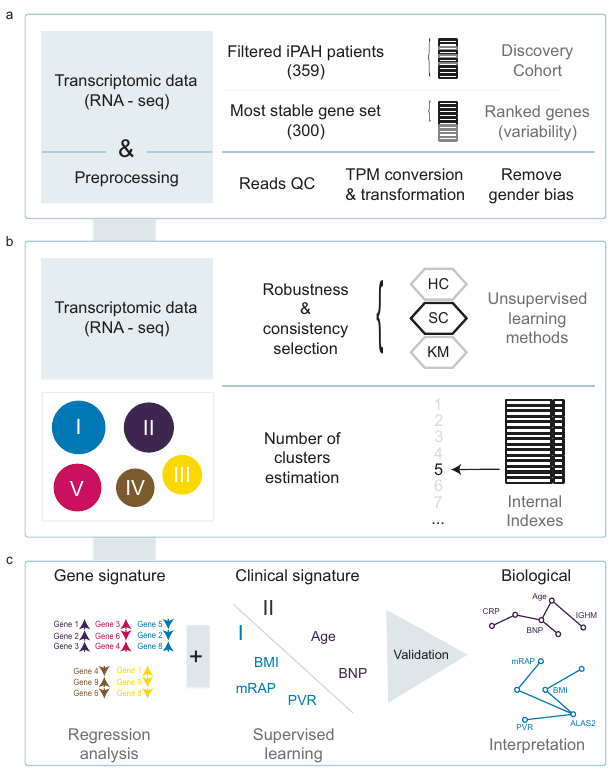
Fig. 1 Overview of IPAH subgroup identi fi cation methodology. a A cohort of 359 IPAH patients and a set of 300 genes are selected for clustering based on RNA data quality and variability of expression across samples. b Spectral clustering of patients using expression values (TPM) was benchmarked against hierarchical clustering (HC) and k -means clustering (KM), and the optimal number of IPAH subgroups was selected based on internal indexes. c Associated gene expression and clinical features were identi fi ed and validated in independent